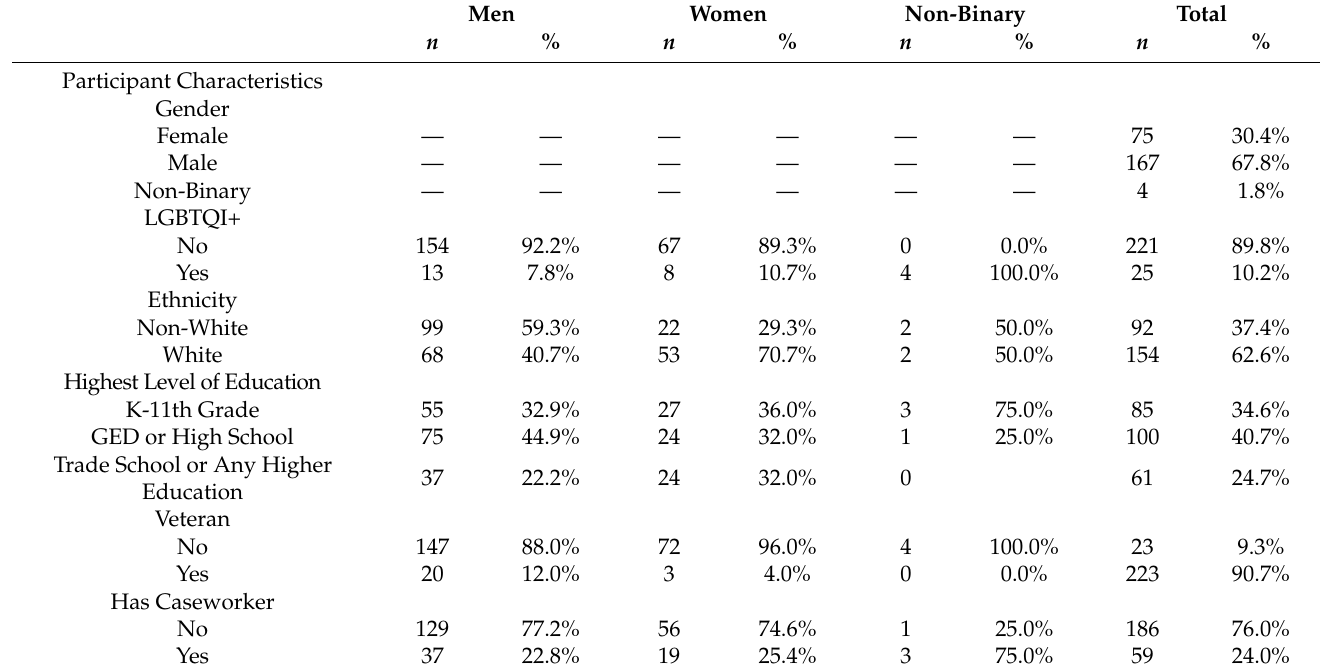
Table 1. Sociodemographic characteristics of n = 246 unsheltered PEH in Nashville,